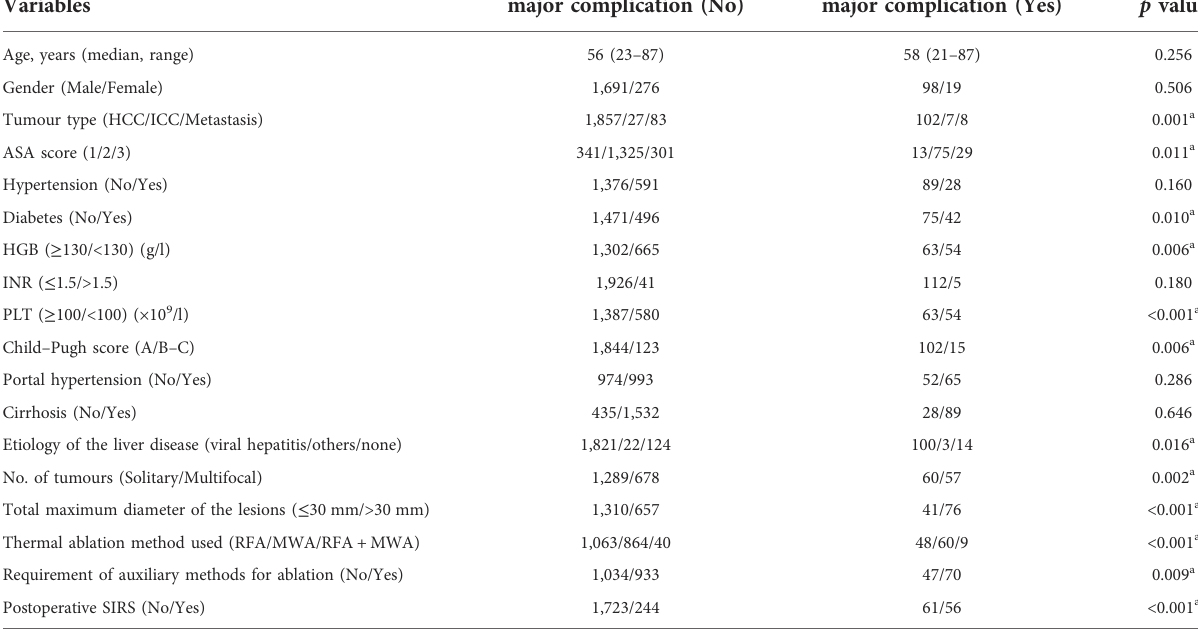
TABLE 3 Univariable logistic regression analyses of risk factors for major complications.